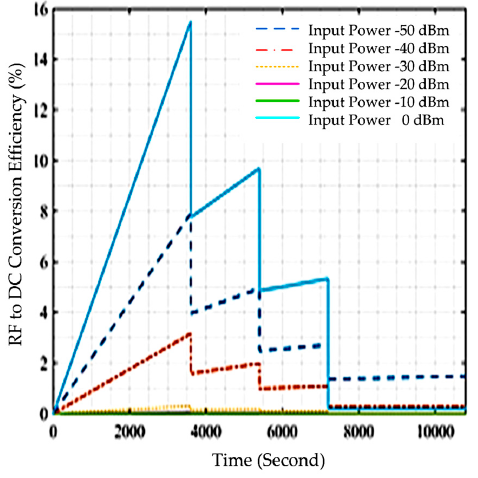
Figure 14. The harvesting antenna and proposed power processing circuit RF-to-DC conversion efficiency versus time.